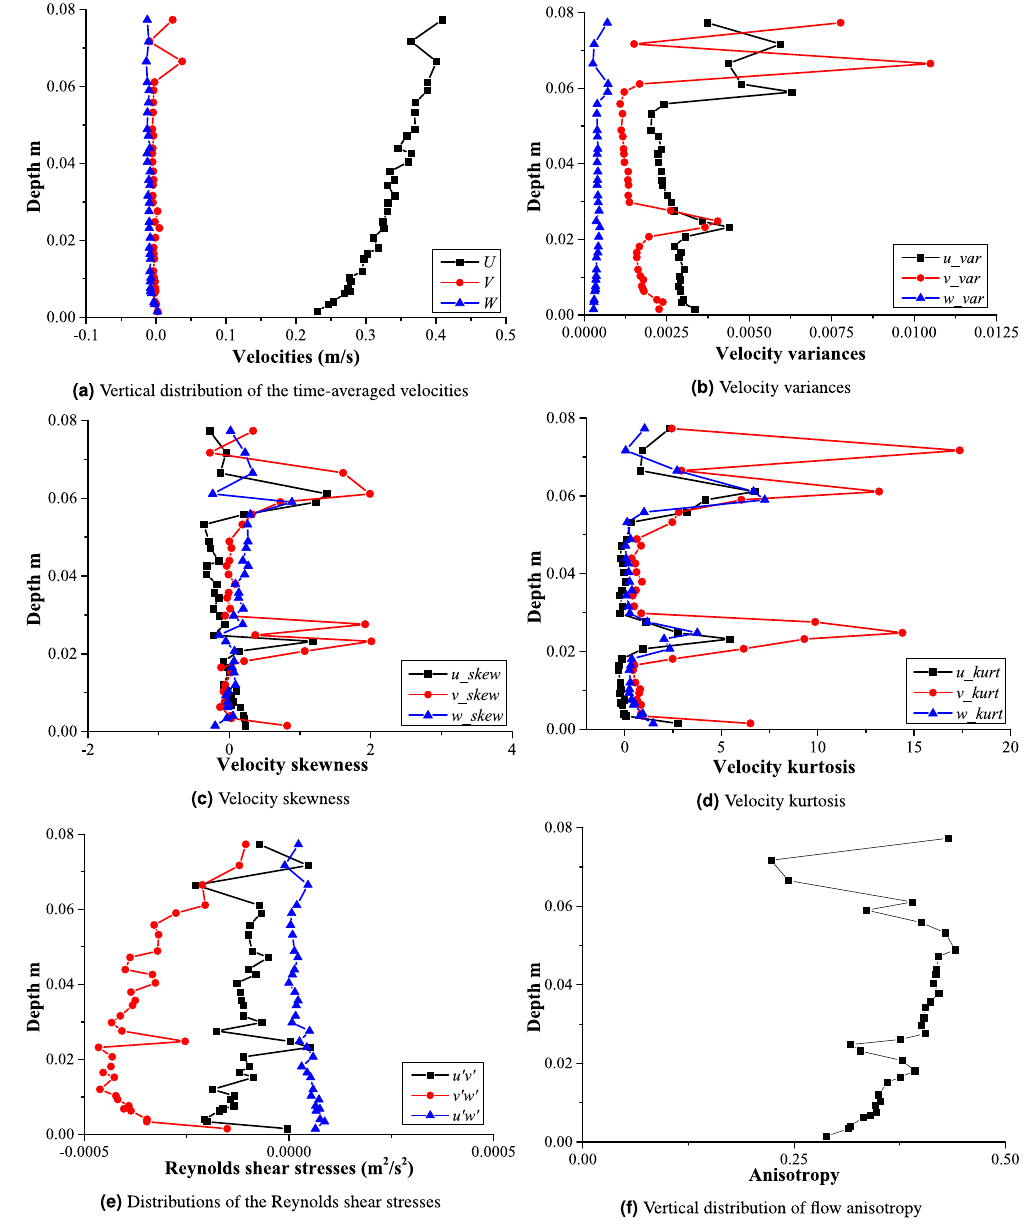
Figure 5. Visualizations that can be derived from the P-SAT